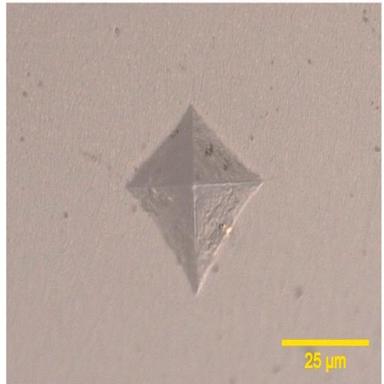
Microscope image of Vickers hardness indentation on sintered zirconia specimen.